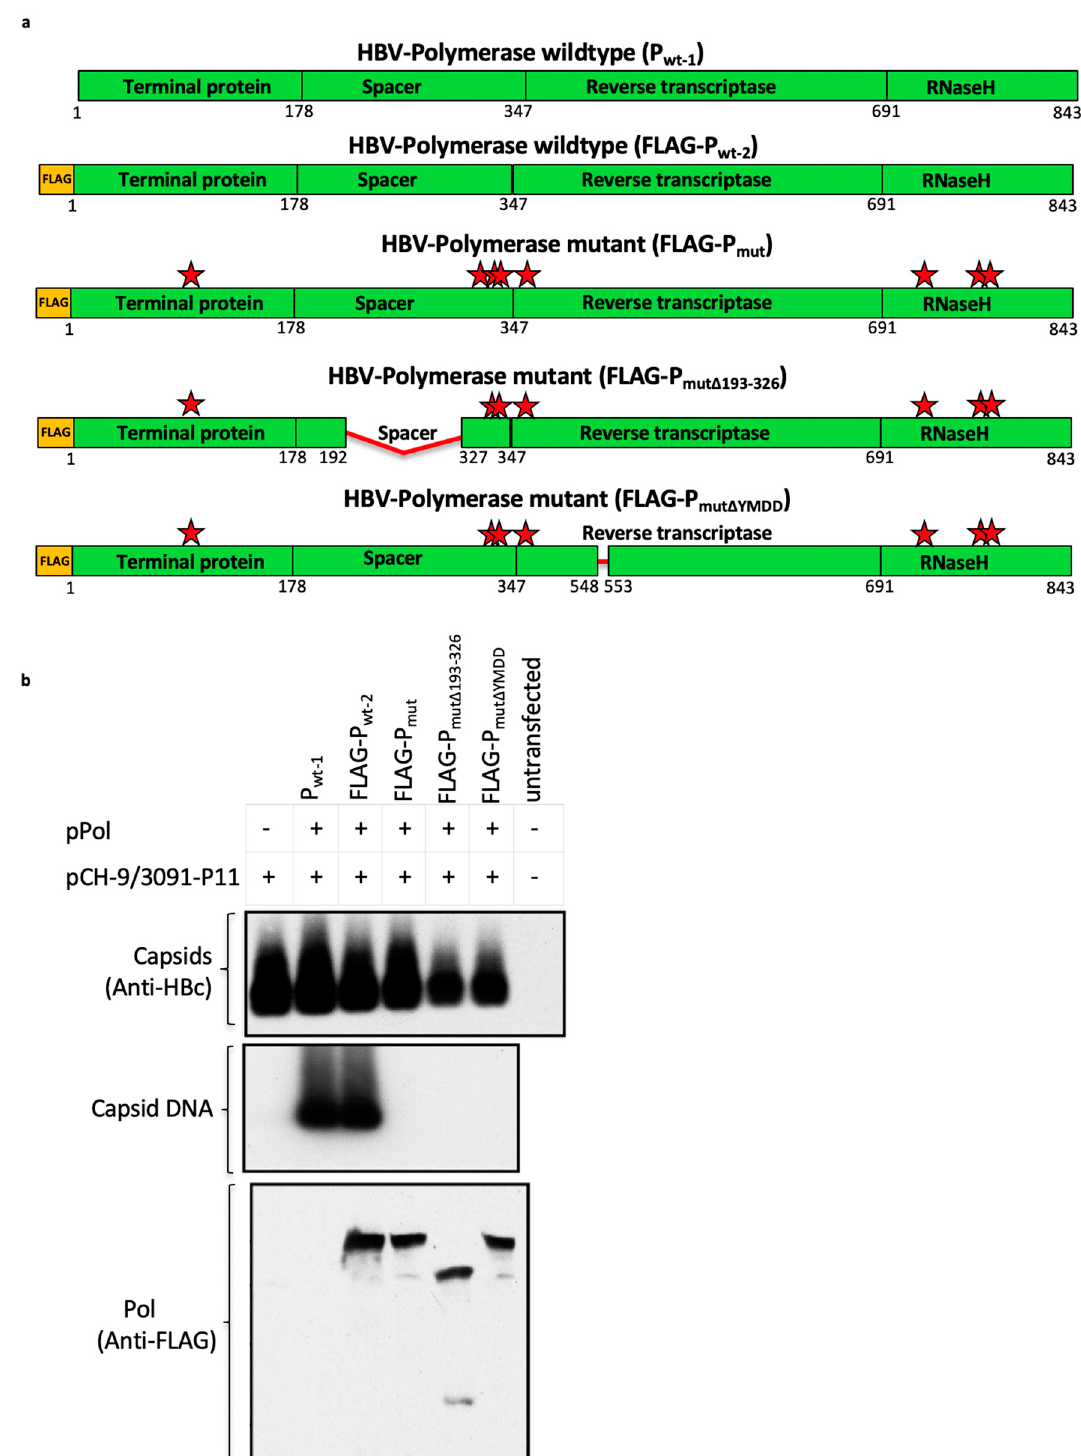
Figure 5. Mutant HBV polymerase (P mut ) encoded by the chimpanzee-adenovirus and modified vaccinia Ankara (MVA) viral vectored HBV vaccines is non-functional. Schematic representation of wild-type (P wt-1 /FLAG-P wt-2 ) and mutant (FLAG-P mut , FLAG-P Δ mut , FLAG-P mut Δ YMDD ) HBV polymerases used to evaluate the possibility of abolishing the functionality of the HBV polymerase encoded in the vaccine using eight-point mutations (FLAG-P mut ; alanine substitutions at positions Y63, C323, C334, C338, C352, R714, D777, R781, represented by red stars) on its own, or in combination with either 193– 326 spacer region deletion (FLAG-P mut Δ 193–326 ) or 549–552 YMDD motif deletion (FLAG-P mut Δ YMDD ) ( a ). Mammalian expression plasmids, each encoding a wild-type (P wt-1 and FLAG-P wt-2 ) or a mutant